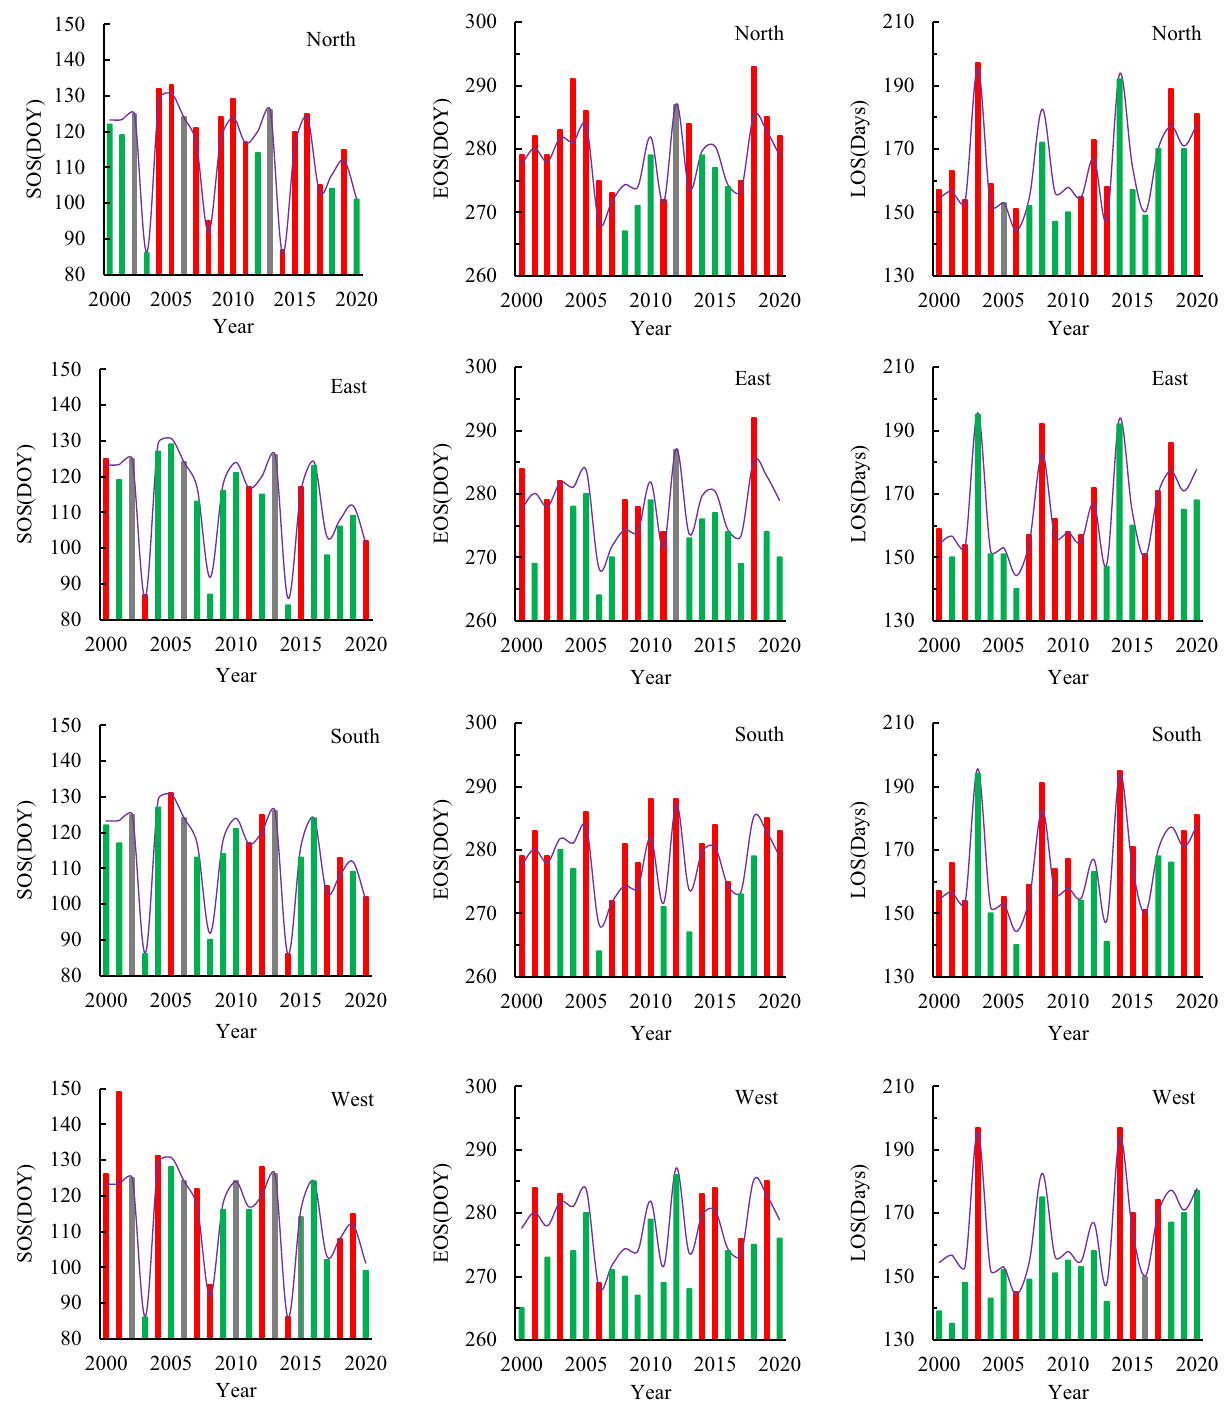
Figure 3. RSP indicators of different aspects (Green represents advance or shortening, red represents delay or extension, and gray represents